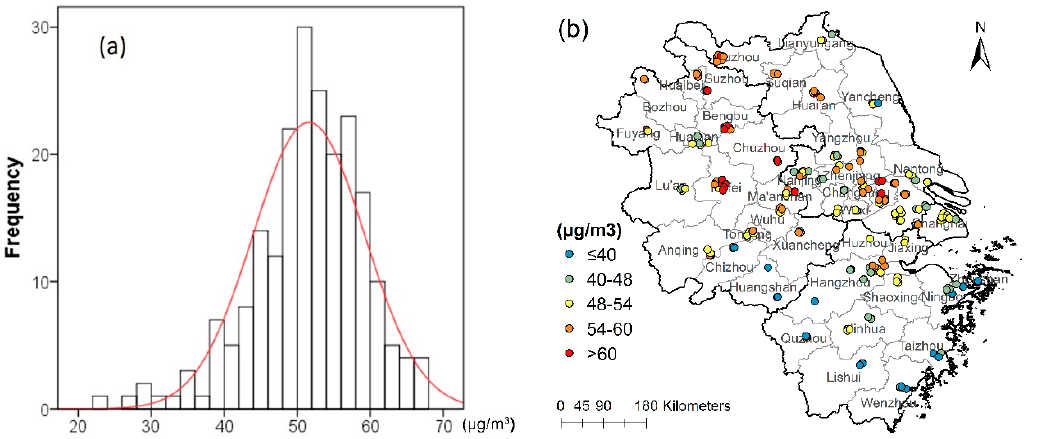
Figure 2. Histogram ( a ) and geographic distribution map ( b ) of the annual mean PM 2.5 ground observations, the red curve is the standard normal curve.